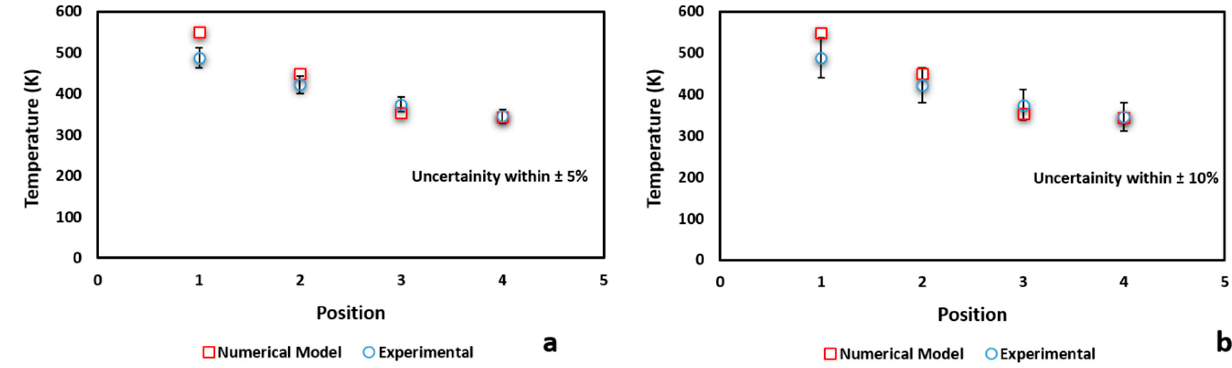
Figure 19. Temperatures measured at peephole 1 obtained using CFD model and experimental tests: ( a ) 5% uncertainty; ( b ) 10% uncertainty.